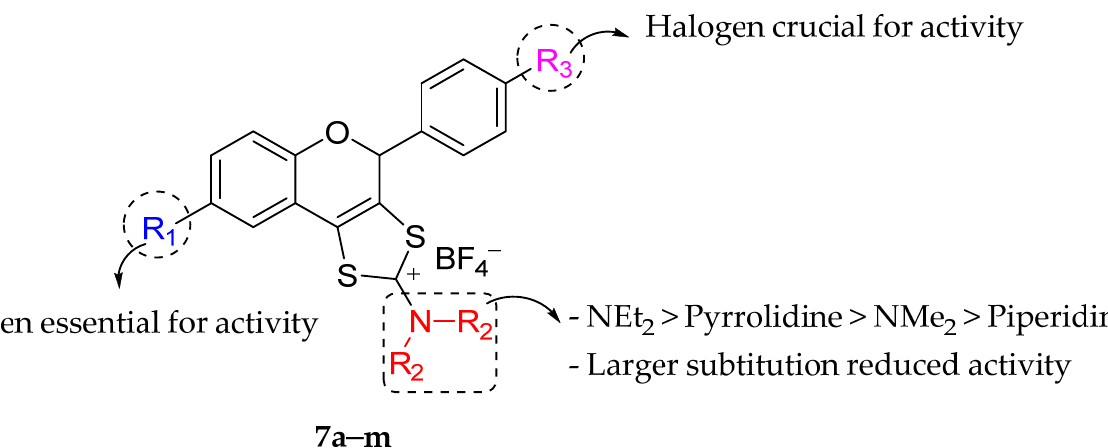
NEt 2 at R 2 exhibited better bacterial inhibition compared to commercialized antibiotics, kanamycin, and ampicillin. Next, halogen substitution at C6 of ring A and C4 (cid:48) of ring B seemed to be important for activity since hydrogen atom substitution at those positions reduced the antibacterial activity, as can be seen in compound 7m [89].